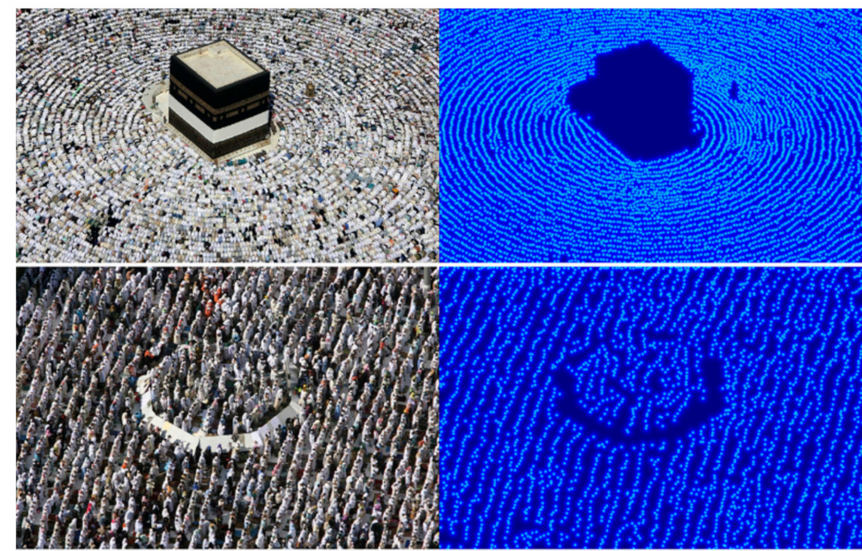
Figure 2. An example of crowd size estimation using Deep CNNs